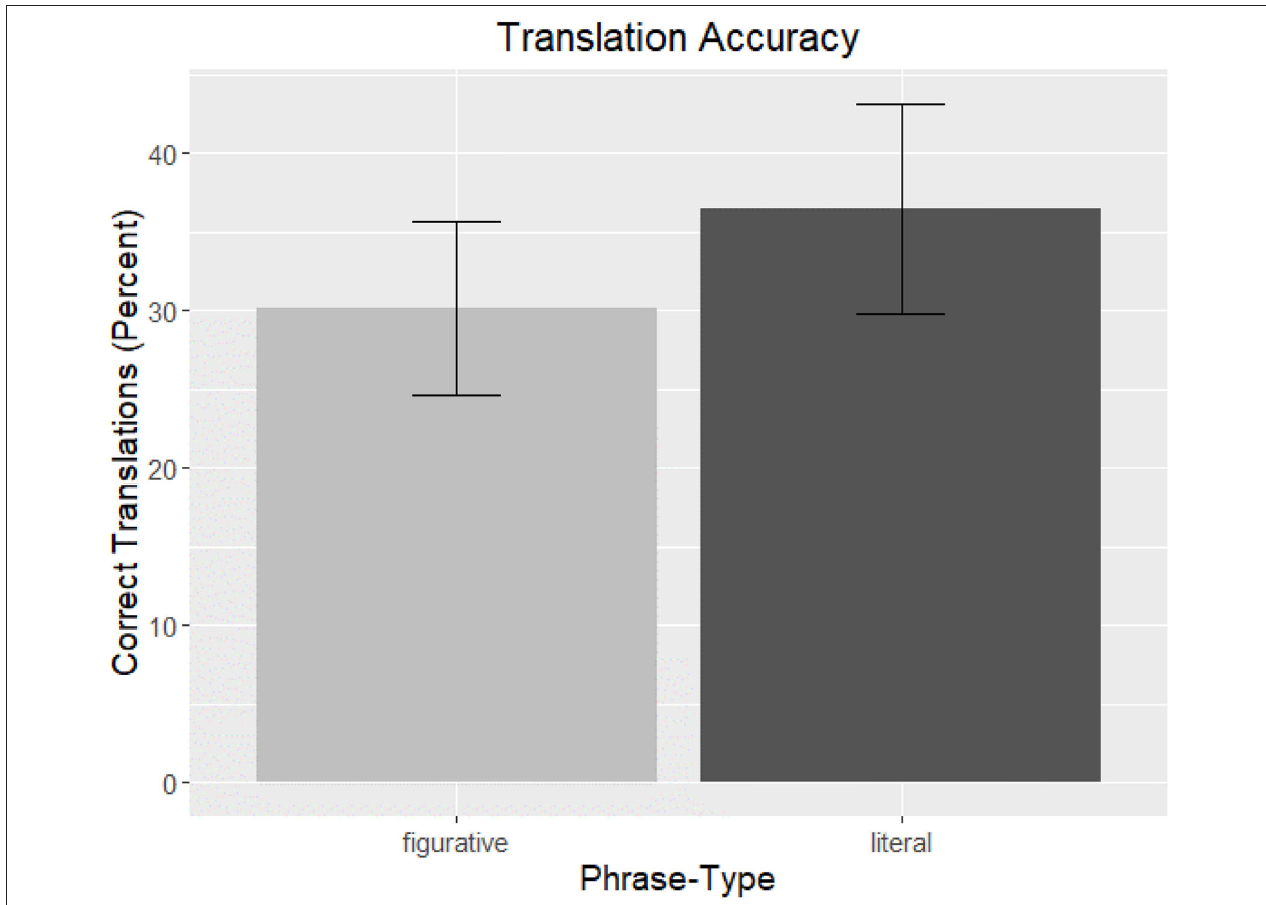
FIGURE 4 | L2 Translation Accuracy. The overall correctness of participant translations of unfamiliar words are graphed as a function of Phrase-Type . Translations occurring in figurative phrases are represented by light gray and literal phrases by dark gray, and bars are the standard error of the mean.